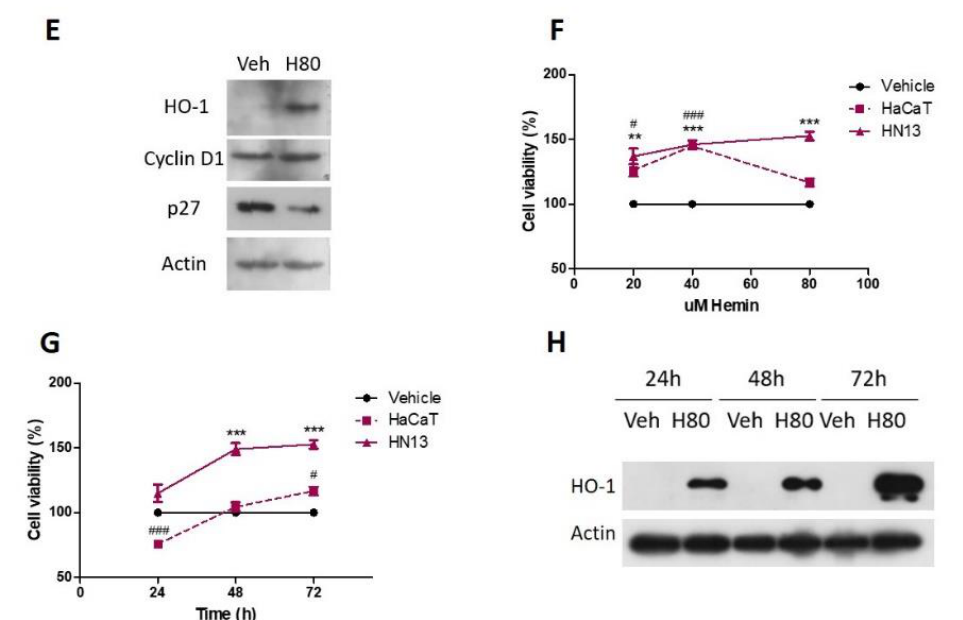
Figure 2. Pharmacological activation of HO-1 promotes cellular viability and cell cycle progression of HN13 cells. ( A ) HN13 cell viability was evaluated after treatment with hemin (20–80 uM) or its vehicle for 24 h to 72 h. ( B ) HN13 cell viability was evaluated after treatment with 80 uM hemin or its vehicle for 24 h to 72 h. ( C ) HN13 cell cycle progression and ( D ) HO-1 protein levels in HN13 cell line were evaluated after treatment with 80 uM hemin (H80) or vehicle (Veh) for 24 h to 72 h. ( E ) Protein levels of cyclin D and p27 after HO-1 activation with 80 uM hemin in HN13 cell line. ( F ) HaCaT cell viability was evaluated after treatment with hemin in dose-response assay at 72 h ( G ) and time-response assay using a 80 uM concentration, comparing the effects with those exerted in HN13. ( H ) HO-1 protein levels in HaCaT cell line were evaluated after treatment with 80 uM hemin (H80) or vehicle (Veh) for 24 h to 72 h. The results are expressed as cell viability percentage = (hemin group × 100/vehicle group). ** p < 0.01 and *** p < 0.001 with respect to the vehicle in HN13 cells. # p < 0.05 and ### p < 0.001 with respect to the vehicle in HaCaT